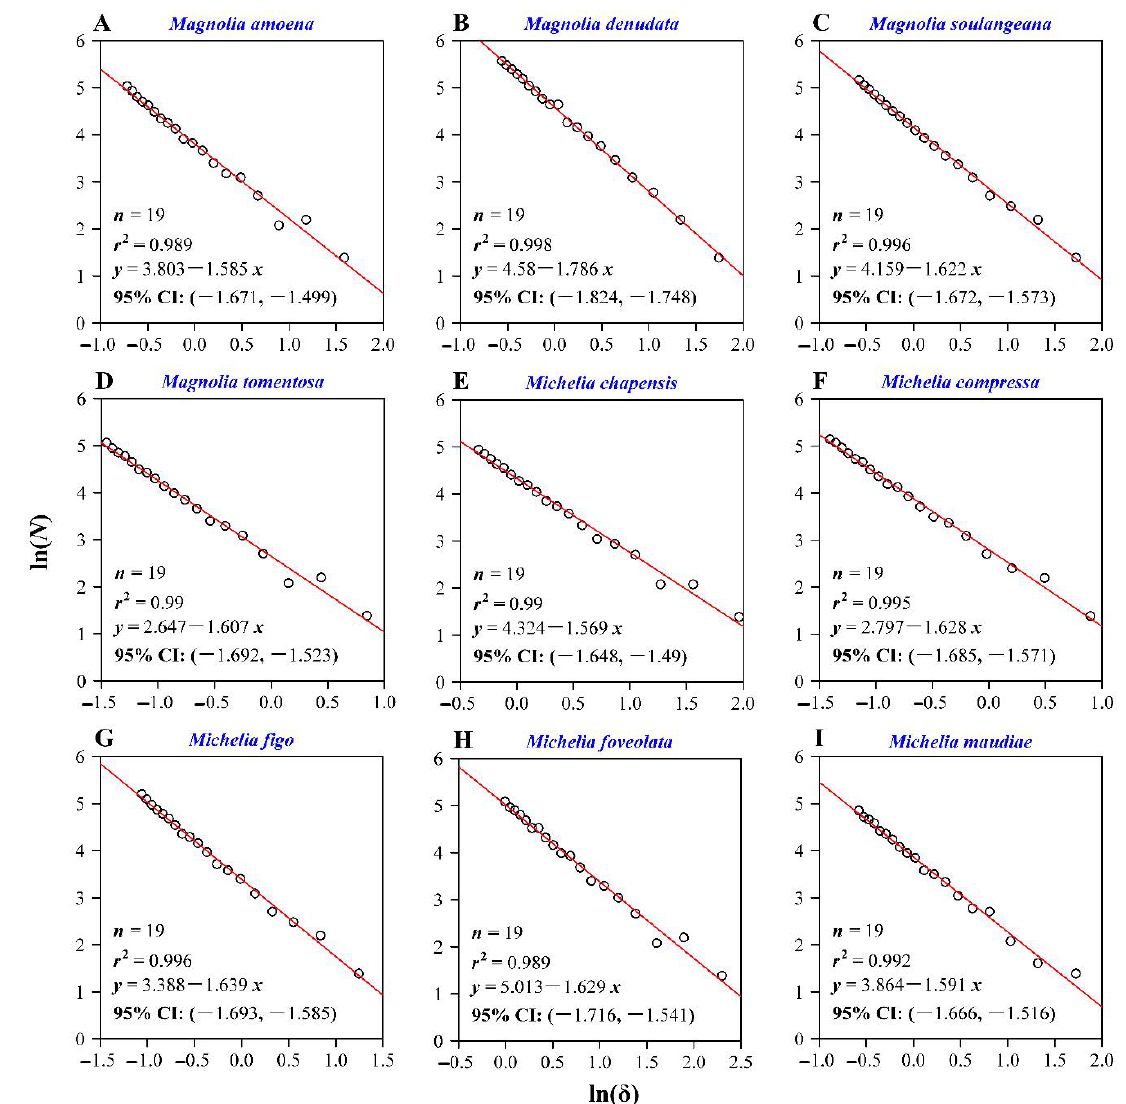
Figure 3. Calculations of the leaf shape fractal dimension for the nine examples ( A − I ). Here, δ represents the box size (i.e., the length of a side of a square); N represents the number of boxes, and each box includes at least one leaf vein pixel; n represents the sample size for each species; r 2 is the coefficient of determination. The absolute value of the slope represents the leaf shape fractal dimension (FD), and 95% CI represents the 95% confidence intervals of the slope. In our study, there are many replicates of leaves for each species, and for each leaf there was a linear fit to obtain the corresponding FD value (i.e., the absolute value of the slope). Because of the limitation of space, we only exhibited the nine fitted results corresponding to the nine leaf examples shown in Figure 1. Table S1 tabulated the fitted results for the remaining leaves investigated.